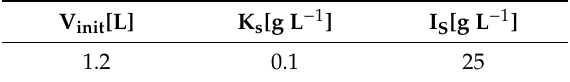
Table A8. Initial concentration volume V init . Model parameters for the monod constant substrate K S and the substrate inhibition constant I S . Parameters estimated by adaptation to previous